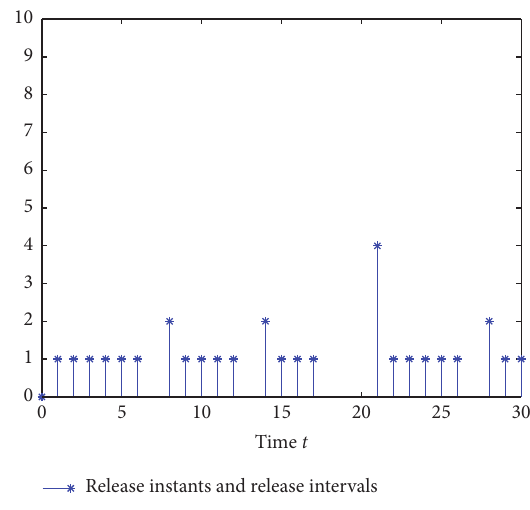
Figure 4: Release instants and release intervals.